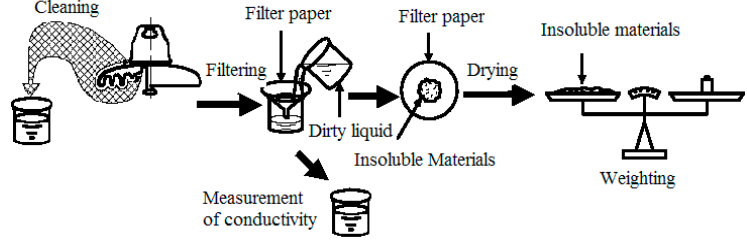
Figure 7. The flowchart of the measuring of the ESDD and NSDD.